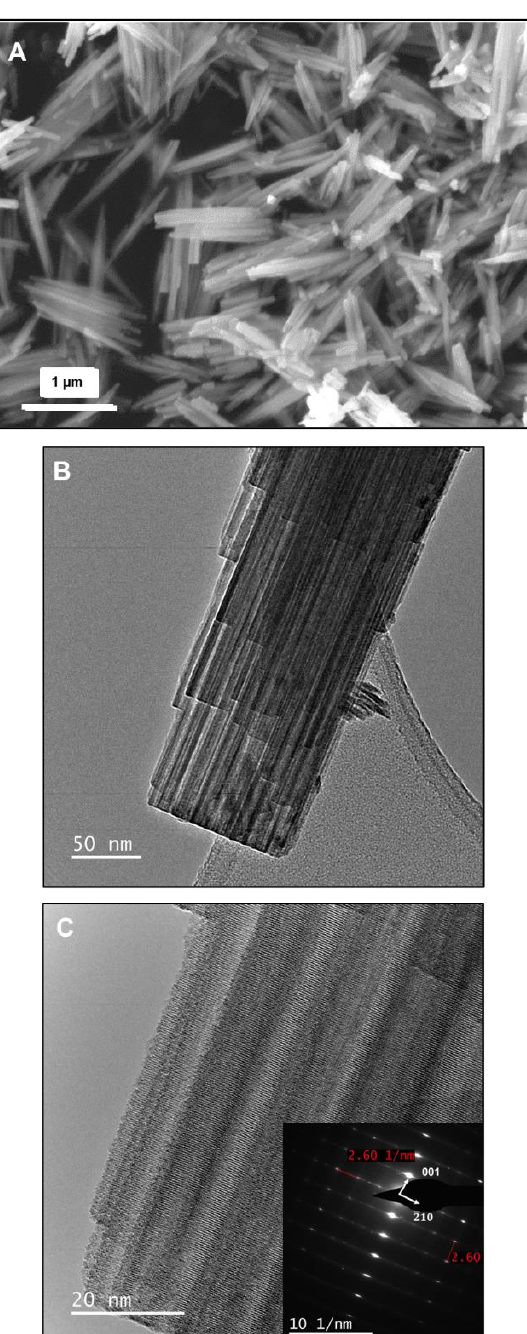
Figure 1. ( A ) SEM image for the agglomerated spiky nanorods of Li-HTB, ( B , C ) TEM images of an isolated nanorod, and an inset of the electron diffraction pattern.